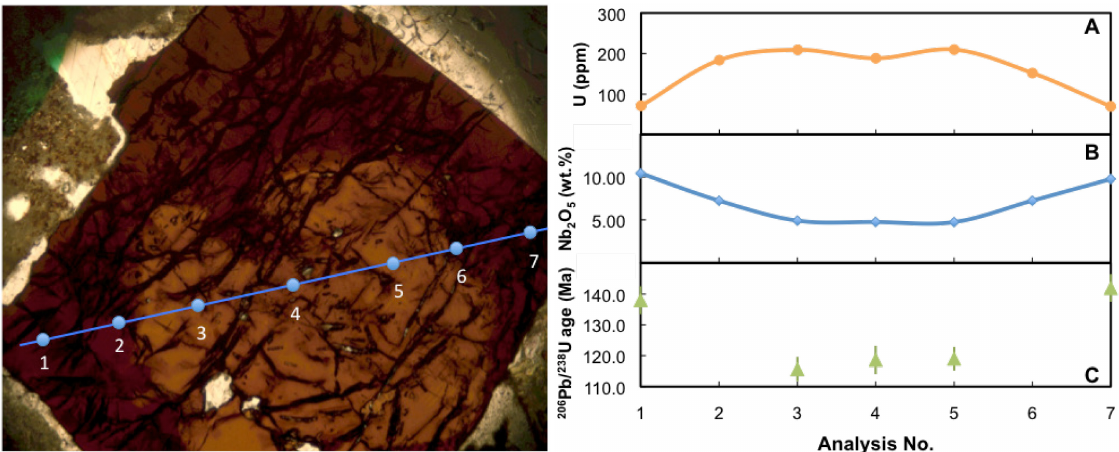
Figure 5. Petrographic image showing the zonation of perovskite. ( A ) U (ppm) concentrations obtained by LA- ICPMS with a 25 μm spot size ; ( B ) Nb abundances analyzed by EMP with a 5 µm beam; and ( C ) 206 Pb/ 238 U weighted mean ages (determined by LA-MC-ICPMS usin g a spot size of 75 μm) across a zoned perovskite grain from sample Oka229 (okaite).